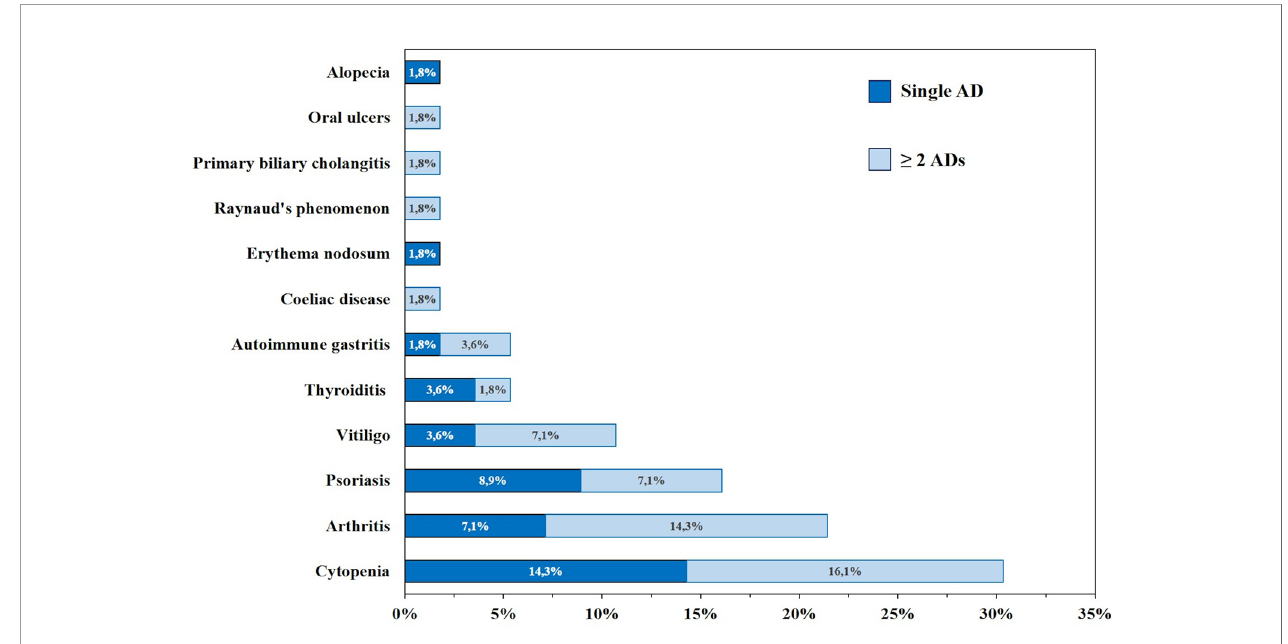
FIGURE 3 | Frequency (%) of autoimmune manifestations presenting alone (dark blue) or in association (light blue) in patients with common variable immunode fi ciency (CVID)